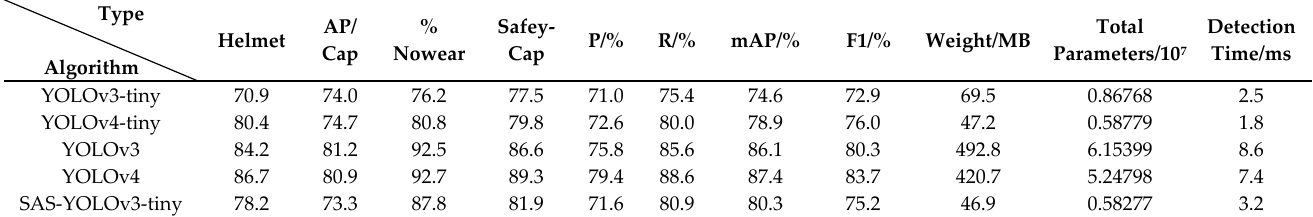
Table 4. Comparison of different algorithms for object detection on the test set.